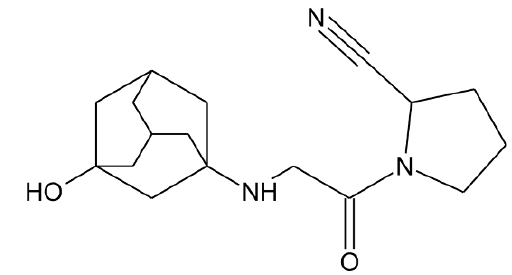
Figure 1. Chemical structure of